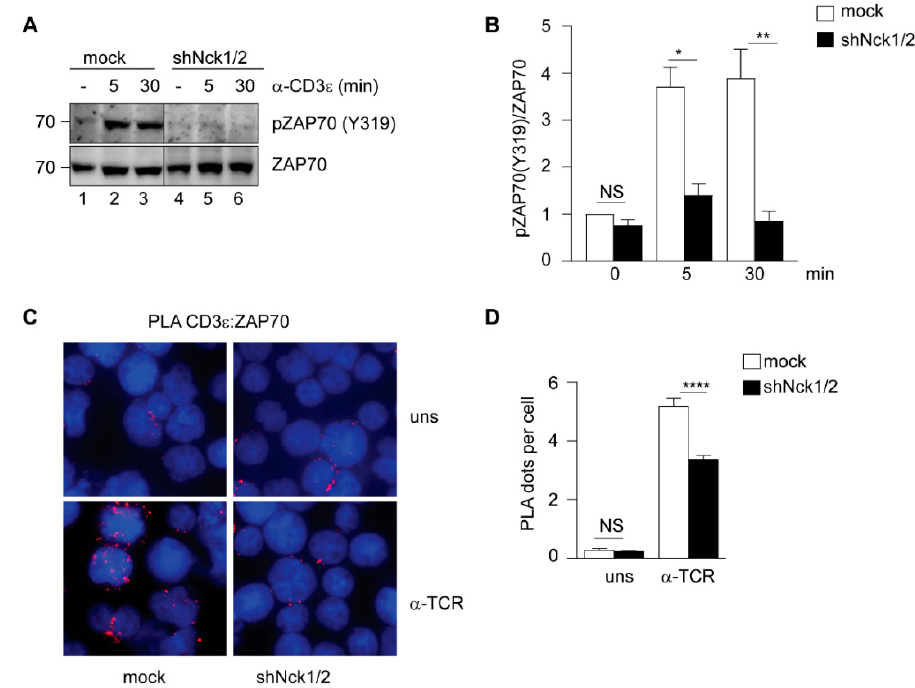
Figure 1. Nck is needed for ZAP70 phosphorylation and recruitment to the activated TCR. ( A ) Mock-treated or shNck1/2 knock-down Jurkat cells were left unstimulated (-) or stimulated with 1 µ g/mL anti-CD3 ε antibody (OKT3) for the indicated times at 37 ◦ C. Total cell lysates were subjected to immunoblot with anti-phospho-ZAP70 (Y319) and anti-ZAP70 antibodies. ( B ) Data from three independent experiments as shown in A were quantified and unpaired Student’s t -test was performed between the indicated samples. ( C ) In situ PLA between the TCR (CD3 ε ) and ZAP70 showing a TCR-ZAP70 distance less than 80nm (red fluorescent signal) in mock-treated or in shNck1/2 knock-down Jurkat cells. Cells were either left unstimulated (uns) or stimulated with anti-TCR (C305) at 37 ◦ C for 5min. Nuclei were stained with DAPI. One representative experiment is shown. ( D ) Quantification and statistical analysis of three independent experiments of data shown in C using unpaired Student’s t -test. Mean values ± SEM are shown. * p < 0.05, ** p < 0.01, **** p < 0.0001, NS, not